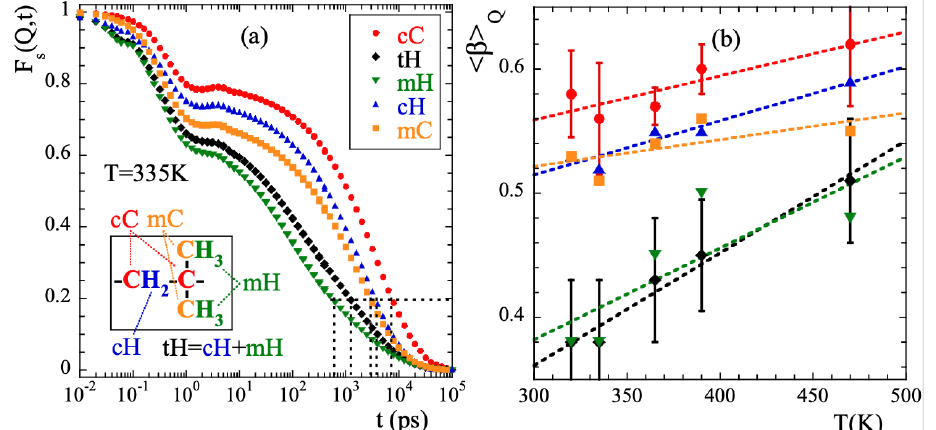
Figure 3. ( a ) Intermediate scattering function calculated for the different kinds of atoms in PIB at − 1 Q = 1.5 Å and 335 K. Horizontal dotted line shows reference level for the definition of τ 0.2 . Inset: Scheme of the PIB monomer illustrating the nomenclature for the different kinds of atoms considered. ( b ) Temperature dependence of the Q -averaged values of the stretching parameter for the different species. Symbols as in ( a ). For the cases of cC and tH, the vertical bars show the range over which the Q -dependent values span at each temperature. Lines are linear regression fits to guide the